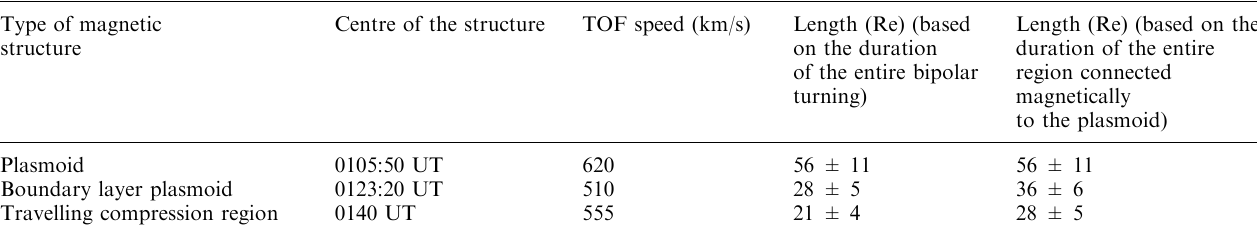
Table 2. Length and TOF speed determination of TCRs Type of magnetic